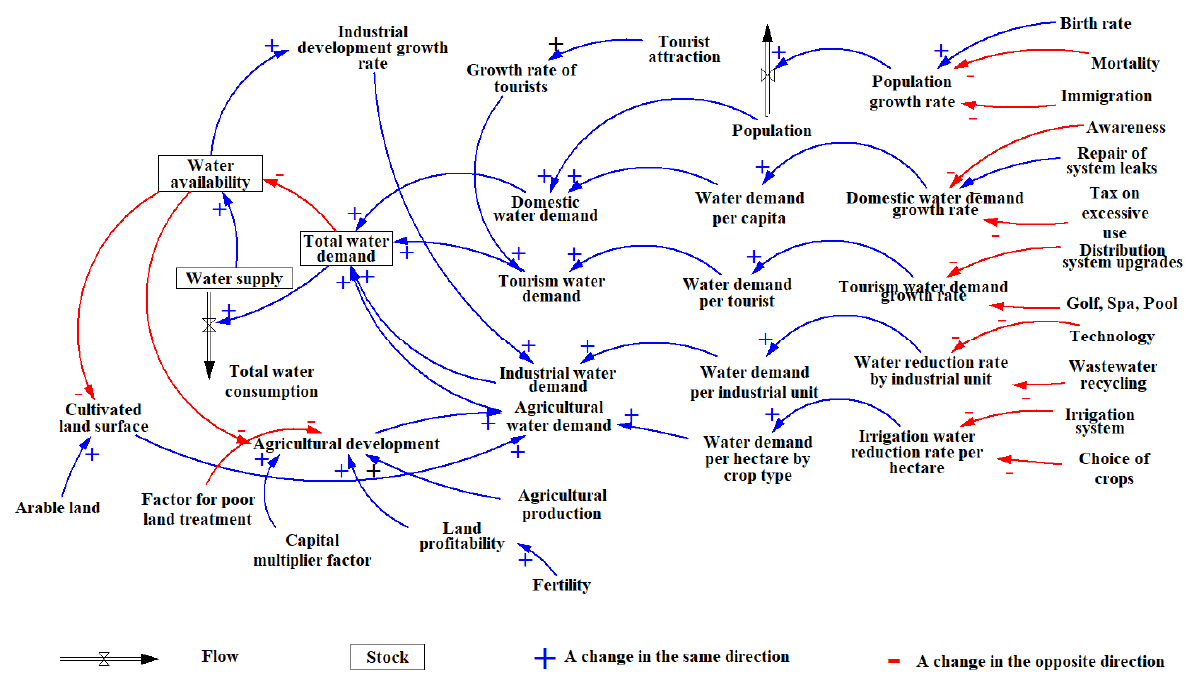
Figure 4. Stock– fl ow diagram showing the interactions between key water demand parameters in Figure 4. Stock–flow diagram showing the interactions between key water demand parameters in the Souss-Massa basin. the Souss-Massa basin.